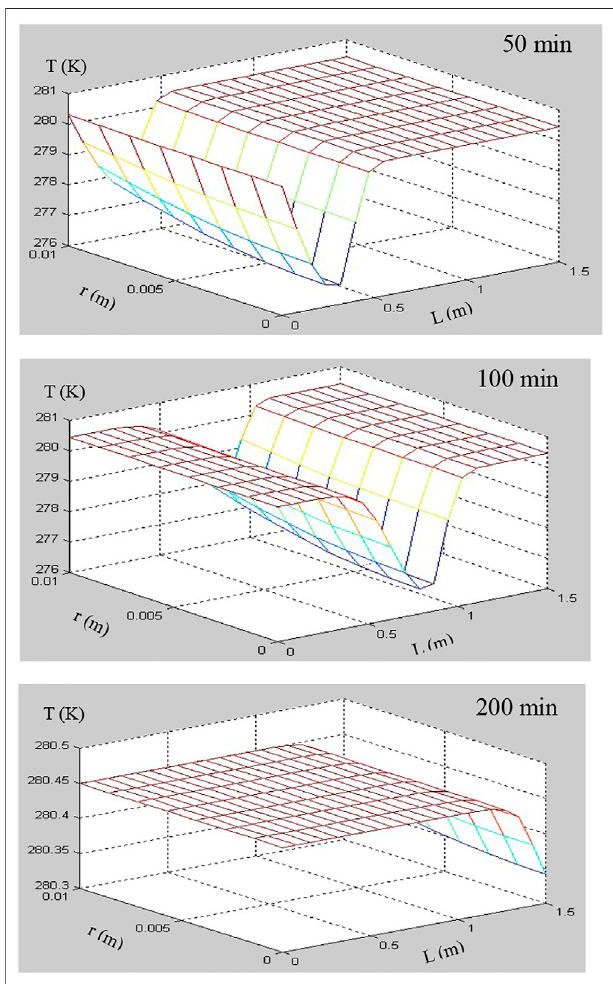
FIGURE 8 | Time evolution of temperature for the initial hydrate saturation of